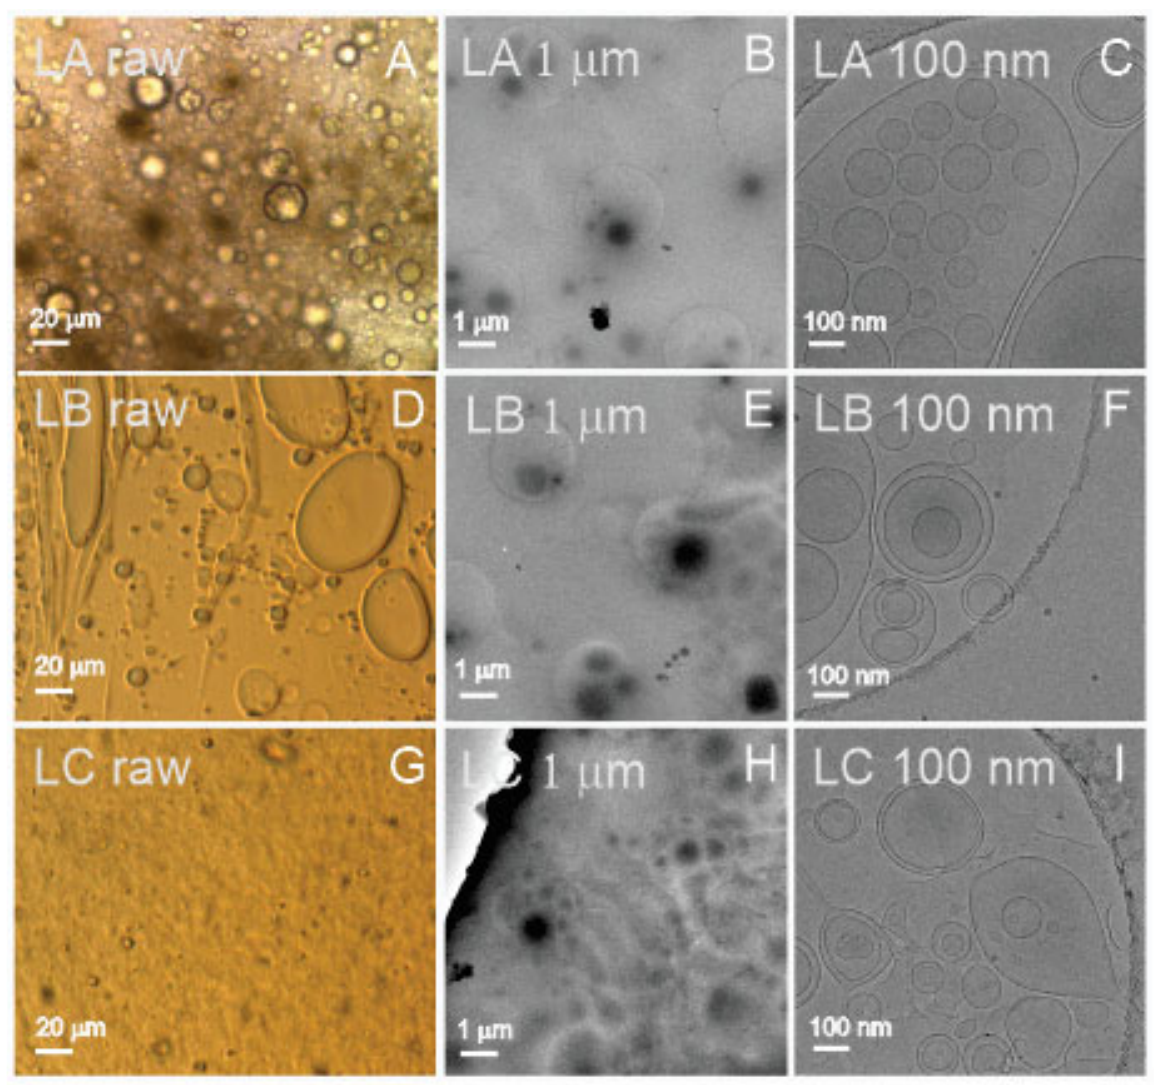
Figure 3. Visualization of liposome samples. ( A – C ): 25 weight% of lecithin, 50% of water, and 25% of glycerol, ( D – F ): 25 weight% of lecithin, 50% of the supernatant from spruce needle homogenate, and 25% of glycerol, ( G – I ): equal weight% parts of lecithin, supernatant from spruce needle homogenate, and glycerol, aged 6 months at room temperature. ( A , D , G ): light microscopy; ( B , C , E , F,H,I ): cryo ‐ TEM microscopy. For light microscopy, the samples were undiluted, while for cryo ‐ TEM, the samples were diluted 500 × . Labels in the upper left corner correspond to labels in the raw data (DOI: